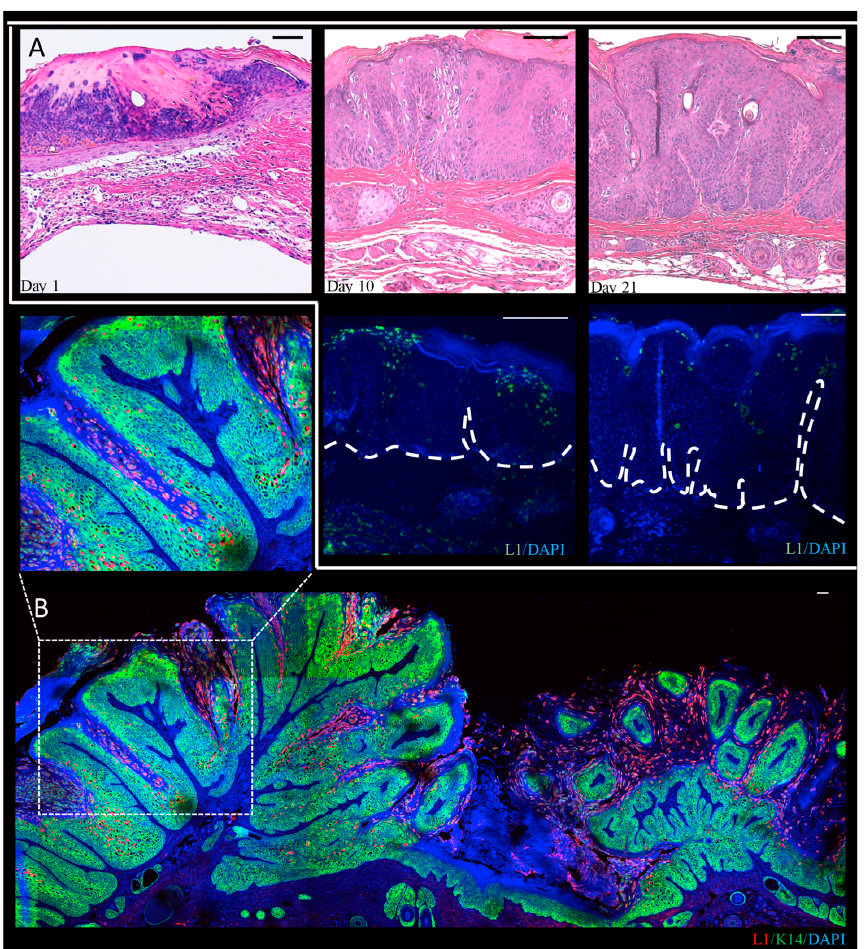
Figure 3. Progression of MmuPV1-induced tail papillomas in BALB/C- FoxN1 nu nude mice. This figure has been adapted and modified from Xue, et al. (2017, in press) [102]. Nude mice were infected with MmuPV1 virus extract following scarification and tissue was harvested at days 1, 10 and 21 post-infection. Panel A shows H&E staining of infected tissue at indicated time points post-infection with MmuPV1 and the corresponding L1 immunofluorescence (green) to show presence of MmuPV1 capsid proteins. At day 1 we see presence of a scab and immune infiltration but no L1 was detected [102]. At day 10 post-infection we can see hyperplasia, and formation of fibrillary projections begin to appear indicating formation of papilloma. At this time point we can detect L1 in the suprabasal layers. At day 21, we can see more pronounced papillomatosis, and L1 staining can be seen even in basal layers of the papilloma. The H&E images and fluorescent images were captured using a Zeiss AxioImager M2 microscope and AxioVision software version 4.8.2 (ZEISS, Jena, Germany). Panel B shows a high resolution wide-field image of an MmuPV1-induced tail wart at 6 months post-infection. In this image we have shown L1-K14 dual immunofluorescence. Extensive papilloma formation coupled with expansion of the K14 layer (green) is seen, and L1 expression (red) is seen throughout the epithelia (inset). The nuclei are stained with DAPI (blue). High resolution wide-field fluorescent images were acquired by means of a super-resolution Leica SP8 STED confocal microscope (Leica Microsystems Inc., Buffalo Grove, IL, USA) equipped with a motorized stage located in the UW optical core. This microscope is equipped with PMT and HyD lasers. All of the images were taken by means of a 20× objective lens (Specifications: HC PL APO 20×/0.75 CS2, Dry). The images were acquired by tile-scanning by marking positions around the region of interest on the LAS-X suite (version: 2.0.1). The merged wide-field image was obtained by automatic stitching of individual styles by means of an in-built auto-stitching algorithm that is part of the LAS-X suite. Scale bar (100 μ m) is shown in top right corner.